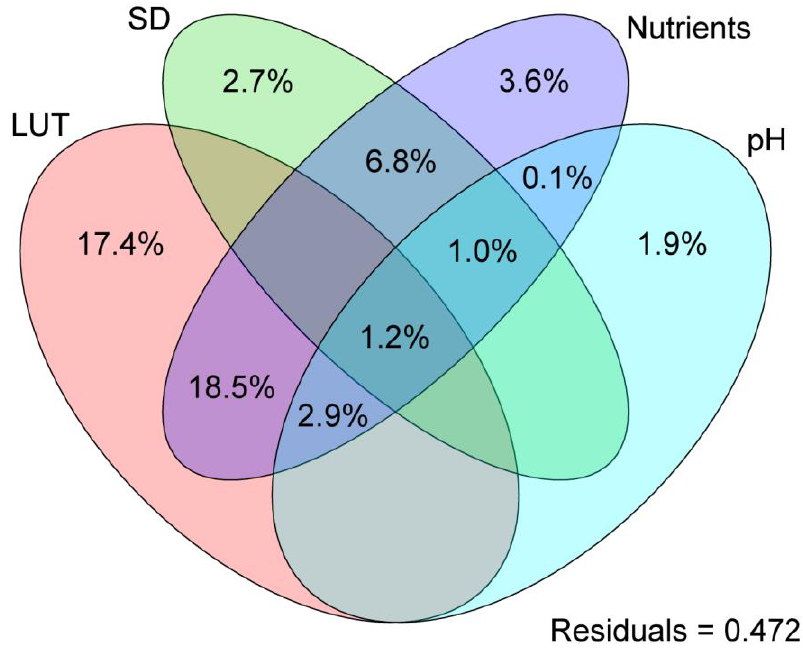
Figure 8. Variance partitioning of the proportion of variation in bacterial community that can be explained by nutrient variables (SOC, TN, TP, AN, NN, AP), different land use types (LUTs), and soil depth (SD), as well as residual unexplained variation. Values < 0 are not shown.